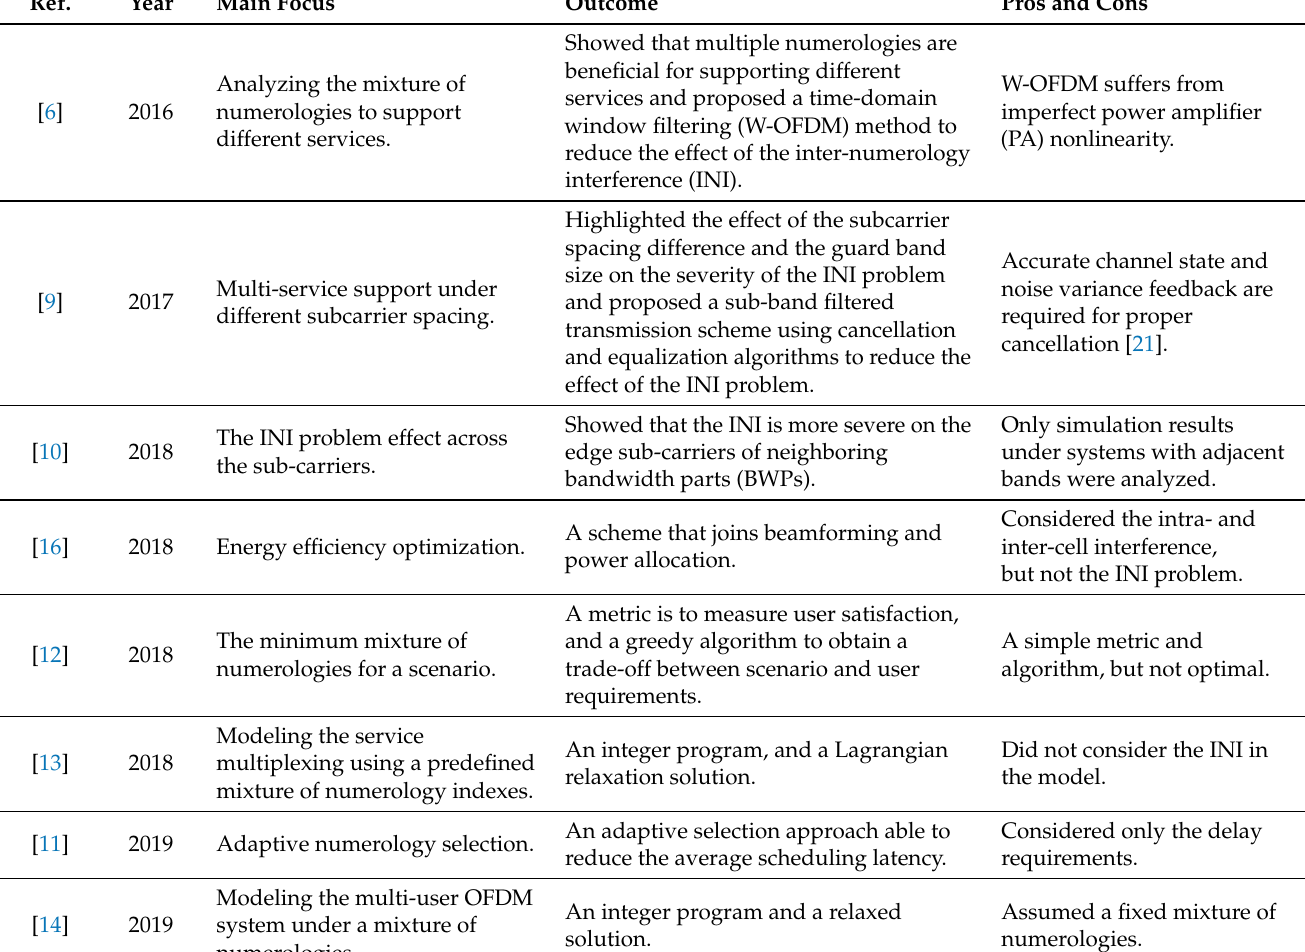
Table 2. Mixed numerology related